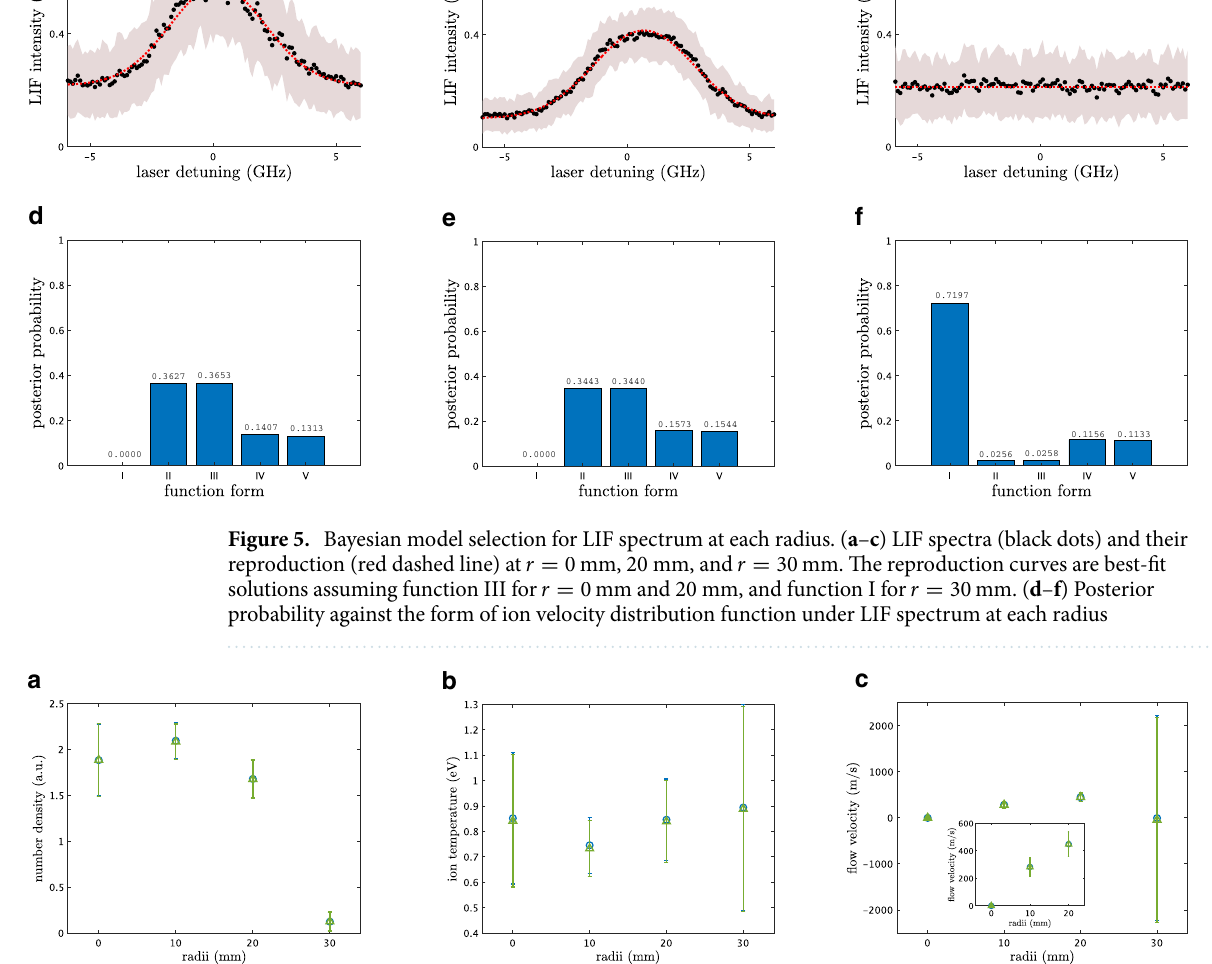
Figure 6. Spatial inhomogeneity in cylindrical helicon plasma. The error bars represent posterior standard deviation. ( a ) Plots of ion density against radii, respectively obtained by assuming functions II (blue circle) and III (green triangle). ( b ) Plots of ion temperature against radii. ( c ) Plots of ion flow velocity against radii. Inset shows the magnified